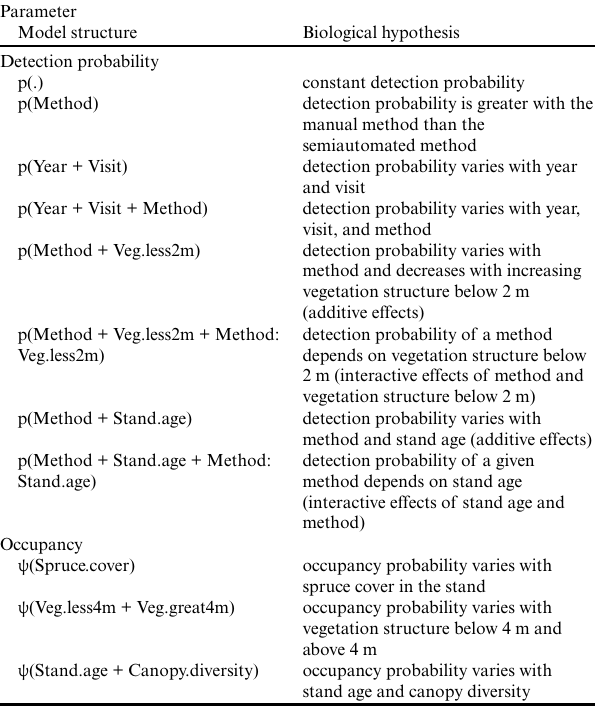
Table 6 . Biological hypotheses tested on detection probability (p) and occupancy ( ψ ) of forest birds from the detection data obtained from recordings spanning each of the four weeks in 2013 and 2014 at 108 stations in Hearst Forest Sustainable Forest Licence, Ontario, Canada. Parameter Model